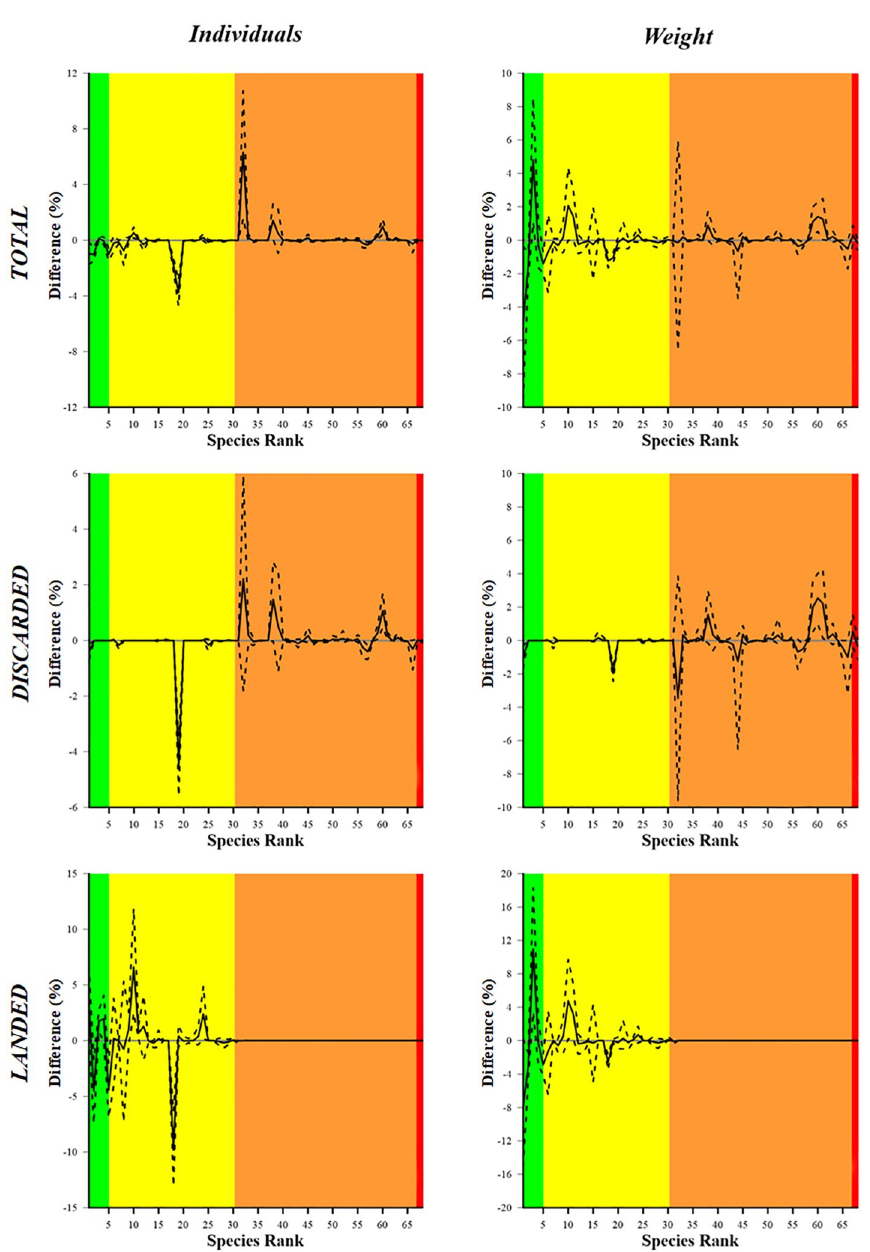
Fig 4. Delta plots resulting from the comparison of the species catch dominance between the DM50 and the SM40, in both number of individuals (left column) and weight (right column). The curves (solid lines) with 95% CIs (dotted lines) are relative to the Total (top), discarded (middle) and landed (bottom) fractions. The 0 grey horizontal line represents an equal proportion between the two codends. The green, yellow, orange and red areas represent the target species, the bycatch species of commercial value, the species of no commercial value and the protected species, respectively.